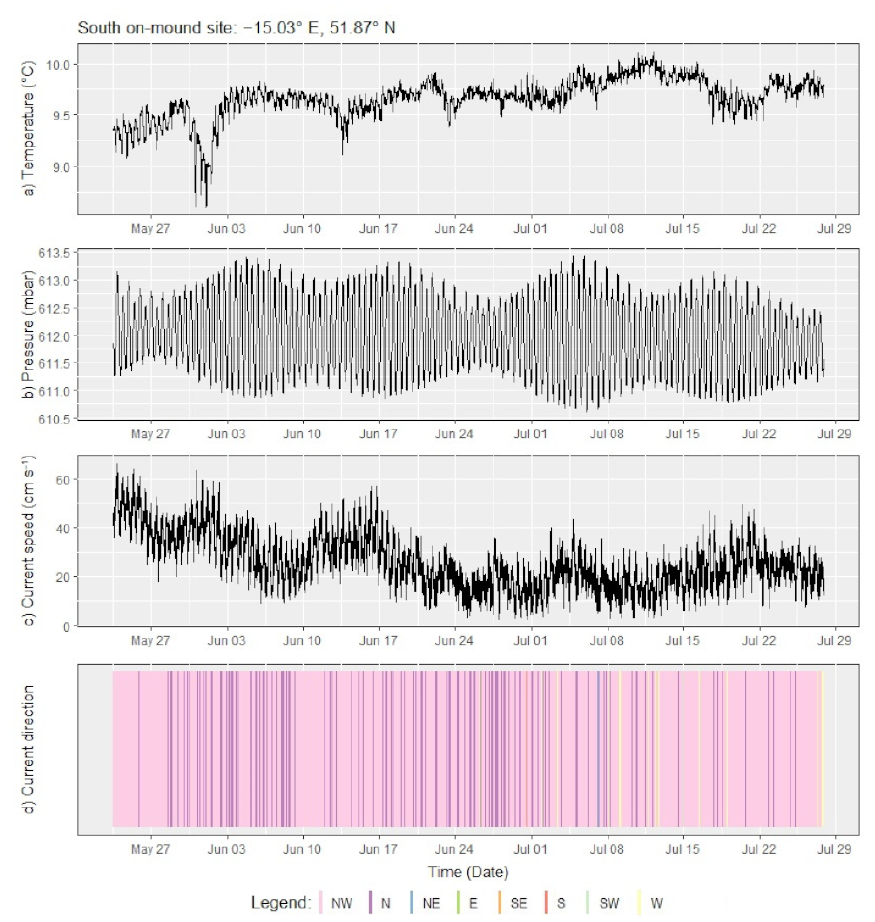
Figure 4. Time series plot of ( a ) water temperature and ( b ) hydrostatic pressure at 1.4 m above the seafloor as well as ( c ) current speed and ( d ) current direction at 3 m above the sea floor with a color legend for the direction on the bottom left. Current speed and direction were measured over a period of one minute in 10-minute measurement intervals, providing >9000 data points per parameter over the deployment